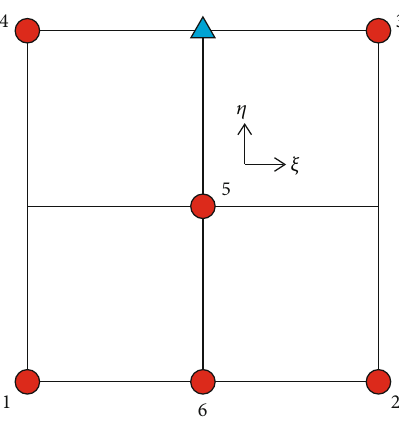
Figure 5: Serendipity element used in spatial interpolation for nodes on the boundary of the fi ne